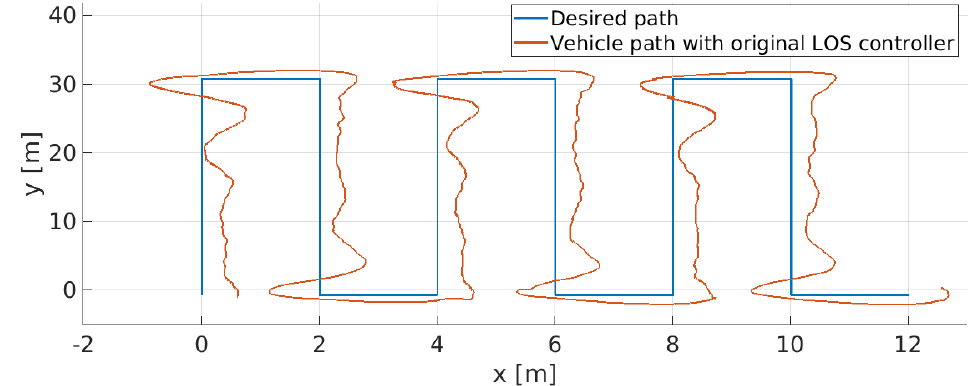
Figure 23. Vehicle’s path, employing the SPARUS II configuration along the test mission.